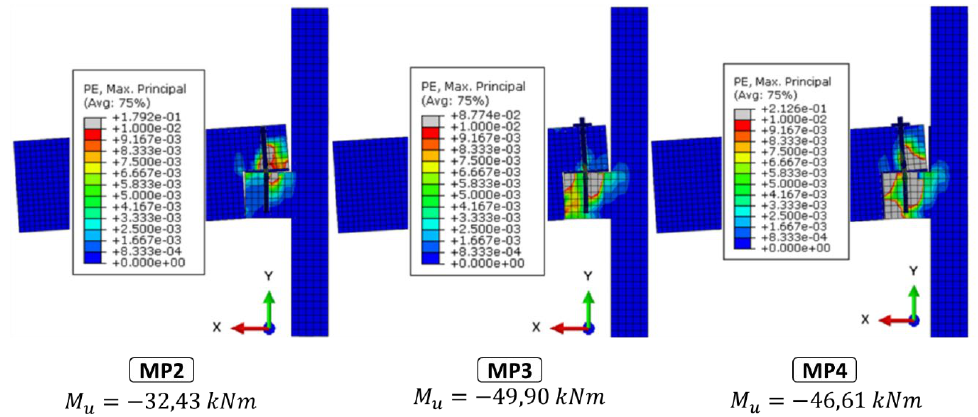
Figure 19. Distribution of plastic strains for M u